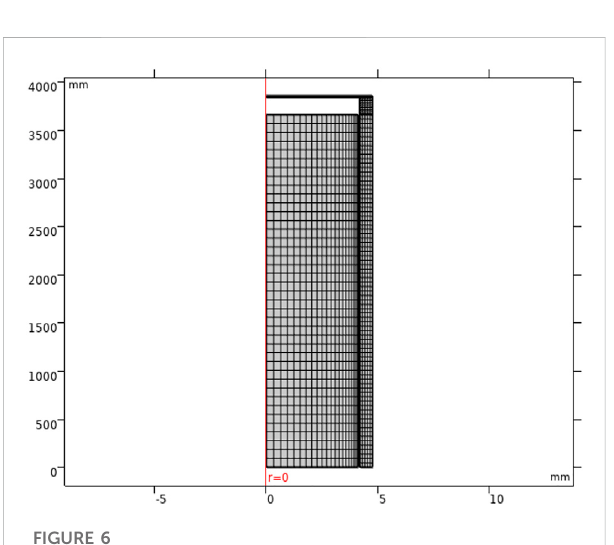
FIGURE 6 Fuel rod mesh used by fuel performance analysis module.